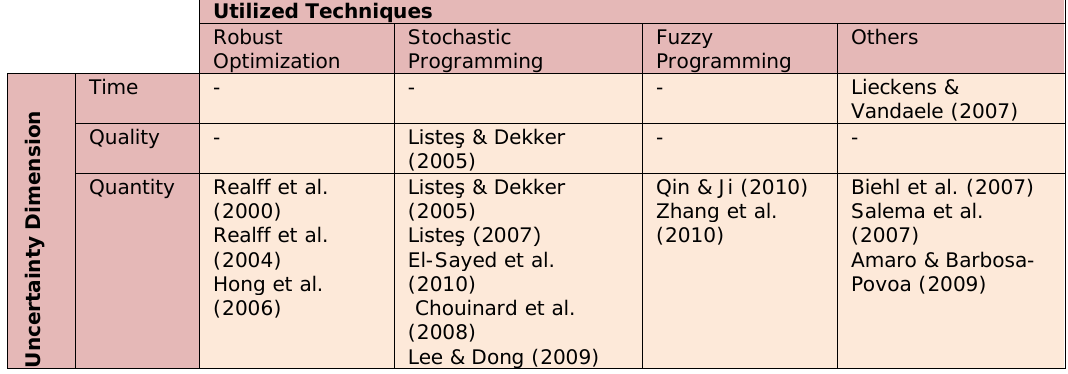
Table 1. RSC network design literature